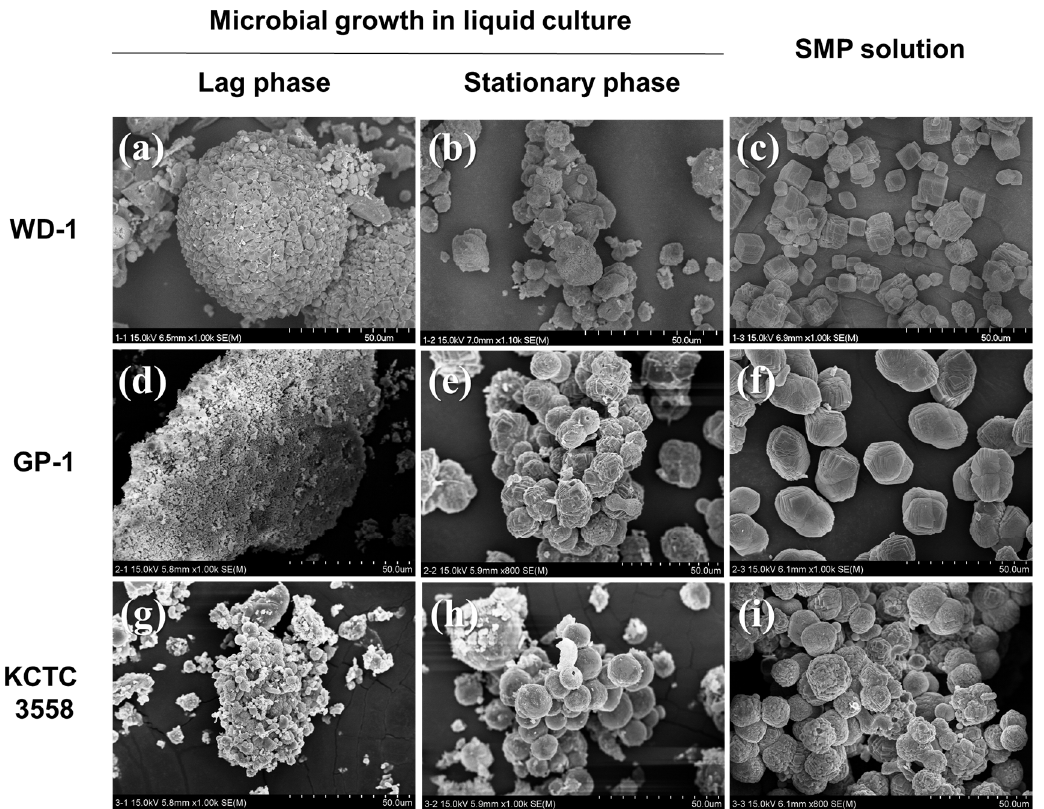
Figure 3. SEM images of Ca-carbonates formed by microorganisms and/or microbial metabolites using Ca-acetate: ( a – c ) WD-1, ( d – f ) GP-1, and ( g – i ) KCTC 3558.